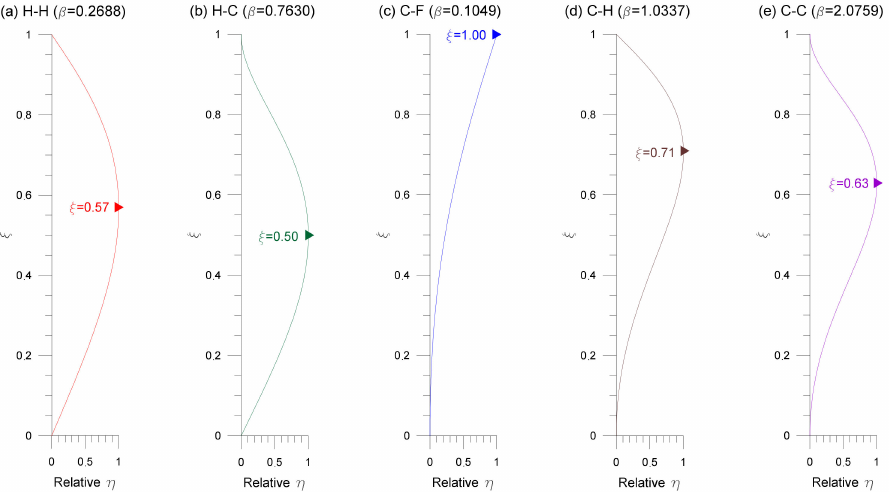
Figure 5. Example buckling mode shapes for λ = 1, k = ∞ , and n = 0.5.